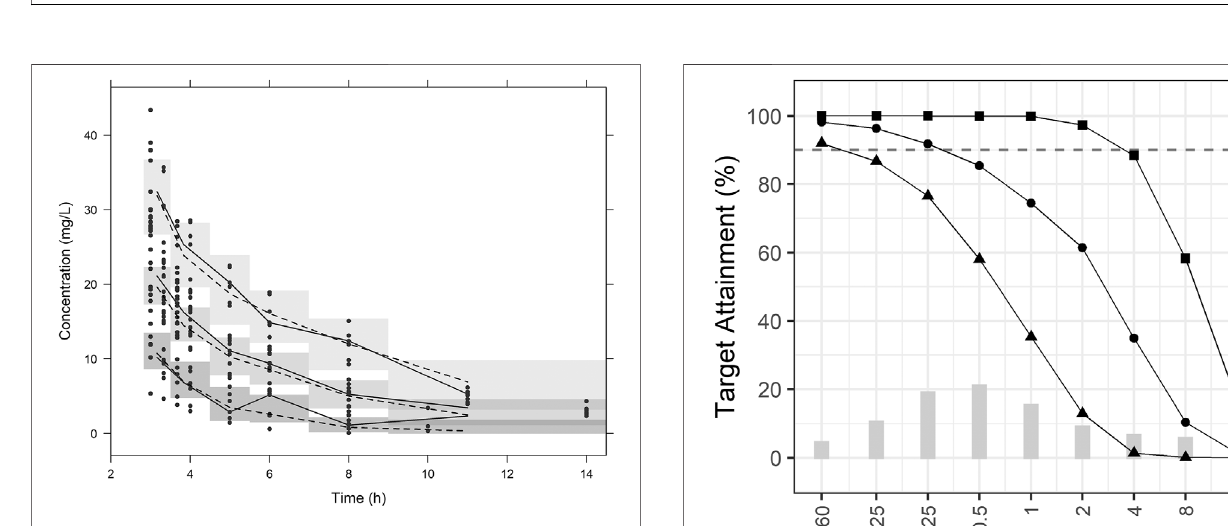
FIGURE1| Goodnessof fi tplots: (A) conditionalweightedresidualsversustime, (B) conditionalweightedresidualsversuspopulationpredictedconcentration, (C) observed concentration versus population predicted concentration, and (D) observed concentration versus individual predicted concentration. The dashed lines are smooth curves.